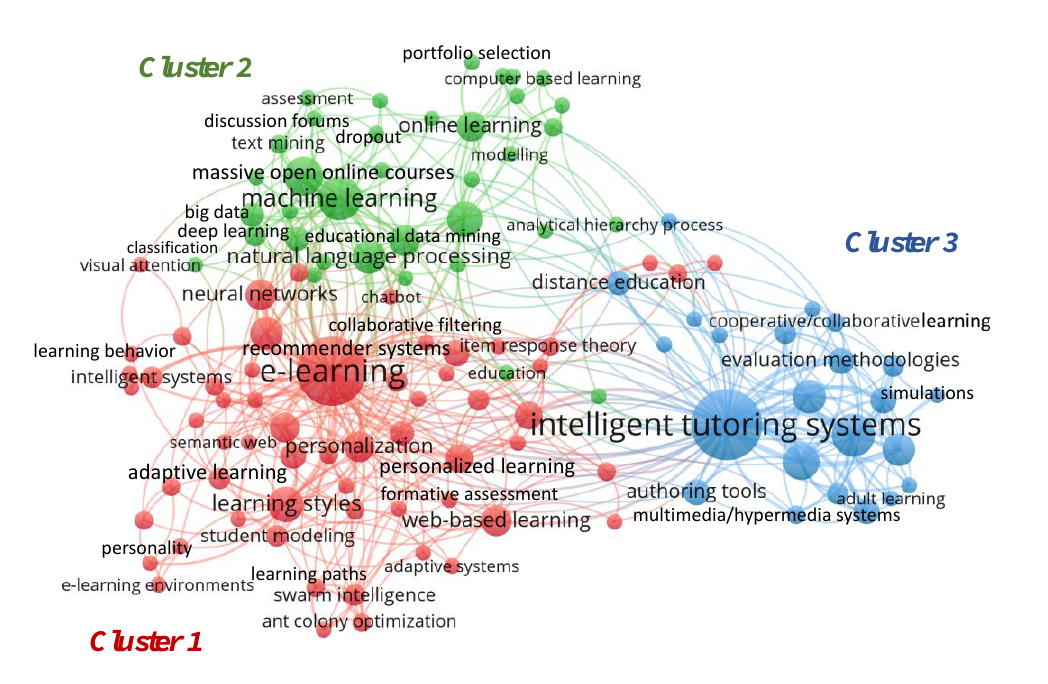
Map of the Structure of Research on AI in Online Learning Environments by